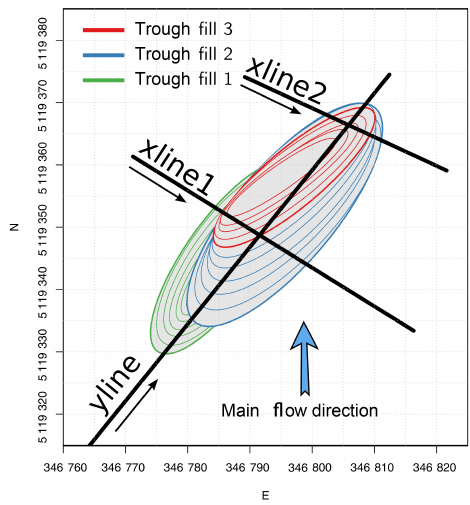
Figure 3. Top view of the geometrical trough fill model (Coordi- nate system: WGS 1984, UTM Zone 33N). The trough fills are rep- resented by green, blue, and red ellipses. The black lines indicate the position of the ground-penetrating radar profiles and the black arrows the GPR survey